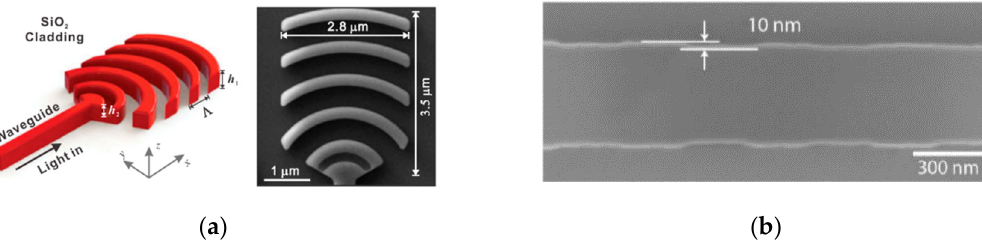
Figure 4. An example of ( a ) a deep-etched focusing grating antenna for 2D OPA ( © 2019 IEEE. Reprinted, with permission, from [54]) and ( b ) a weak coupling strength linear grating antenna for 1D OPA (adapted with permission from [68] © The Optical Society).